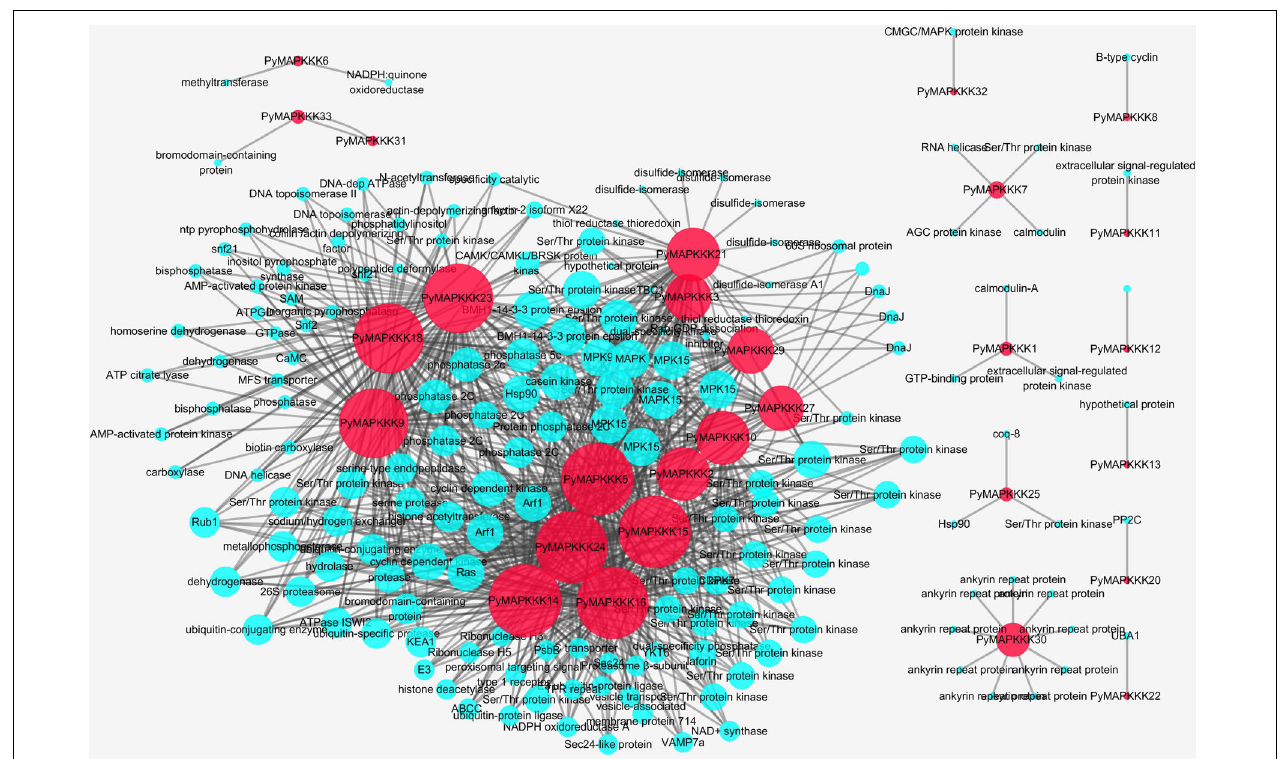
FIGURE 7 | The interaction network of PyMAPKKK genes in P. yezoensis. The red circle identifies PyMAPKKKs, the blue circle identifies interacted genes with